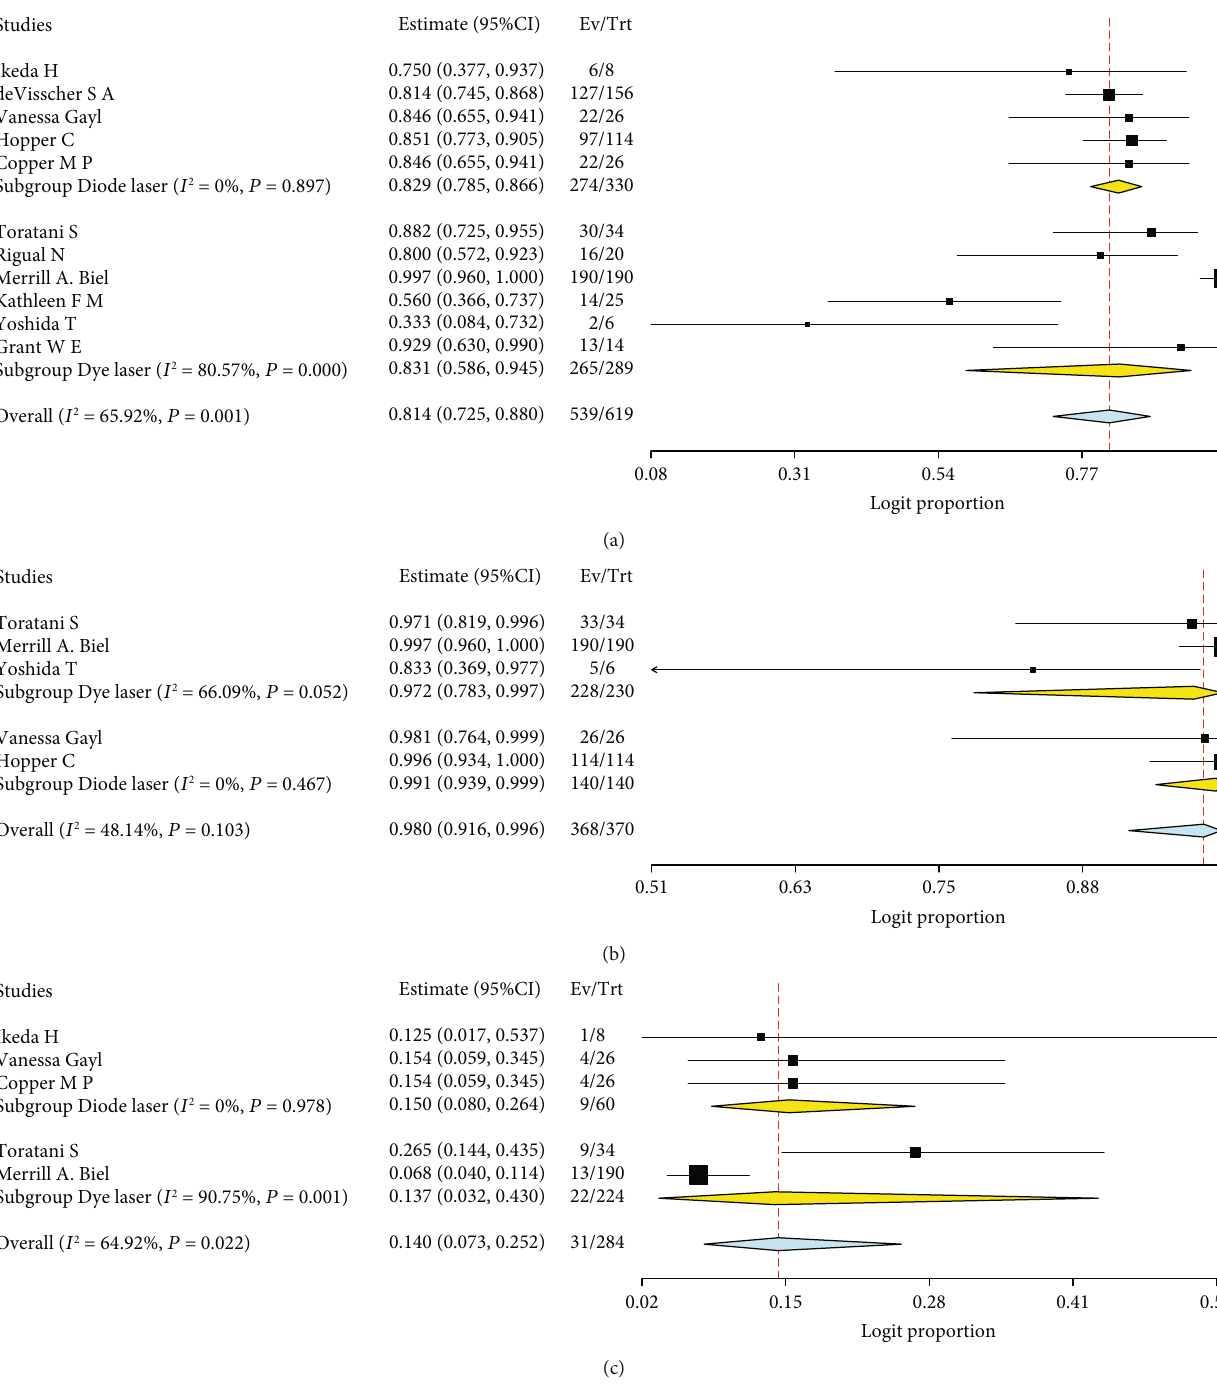
Figure 7: Forest plot of subgroup analysis of (a) CR, (b) OR, and (c) RR in cases using di ff erent laser